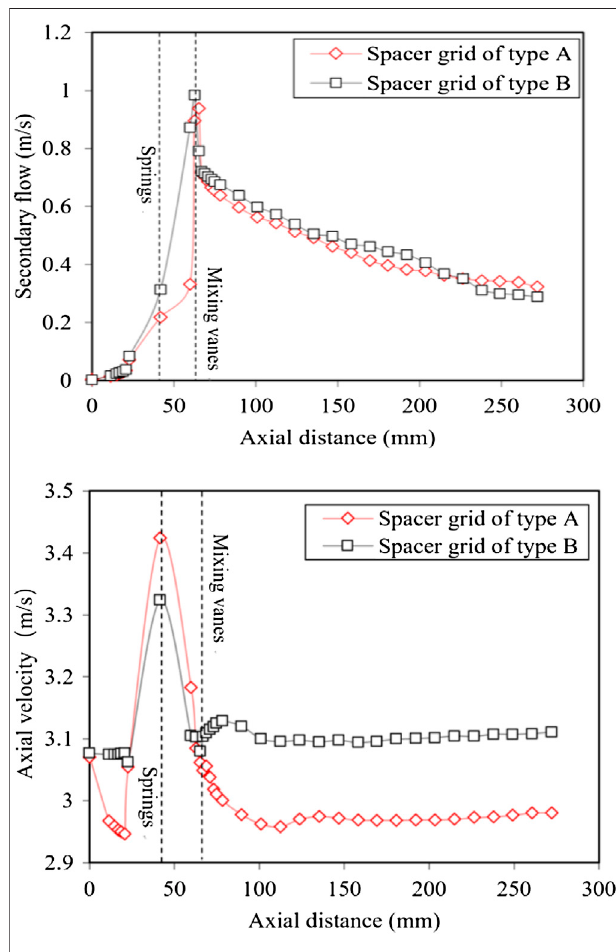
FIGURE9| Distributionofvelocityalongaxialdirectionfordifferenttypes of the spacer grid.